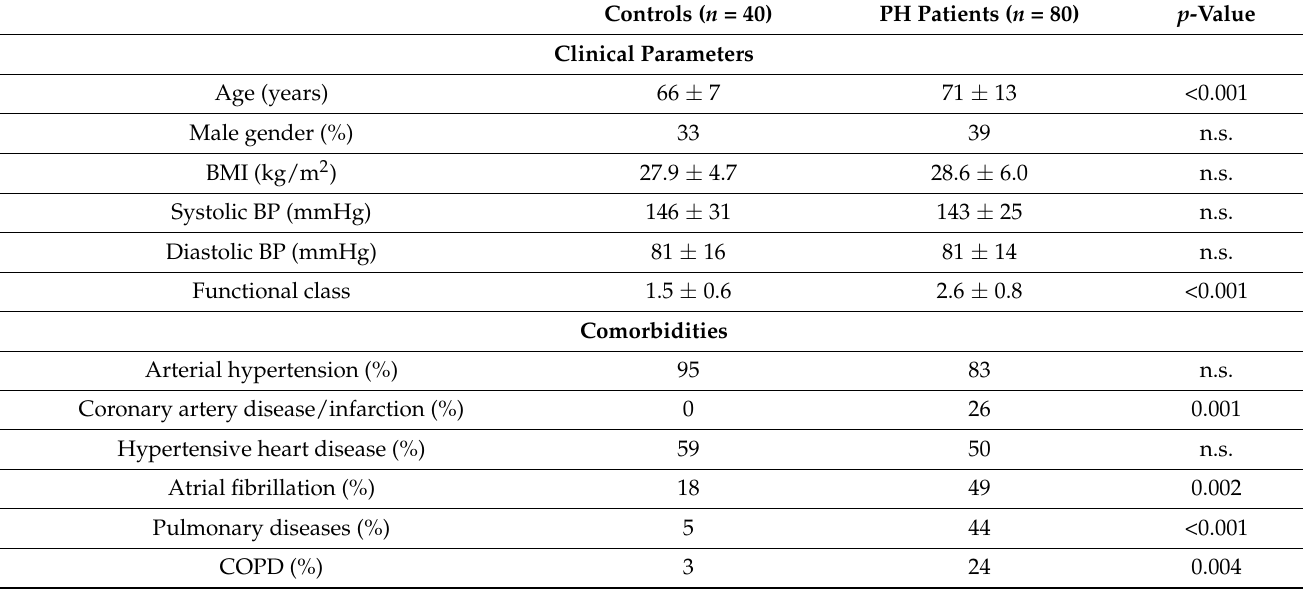
Table 1. Characteristics of the study groups in comparison between the PH patients in the total ( n = 80) and controls ( n = 40). Controls ( n = 40)